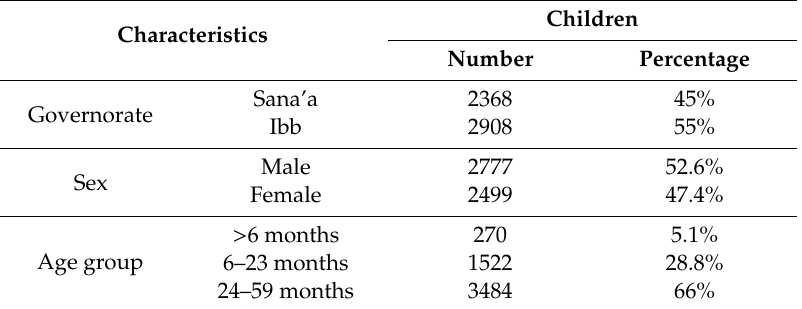
Table 2. Demographic characteristics of children under five in Ibb and Sana’a governorates.